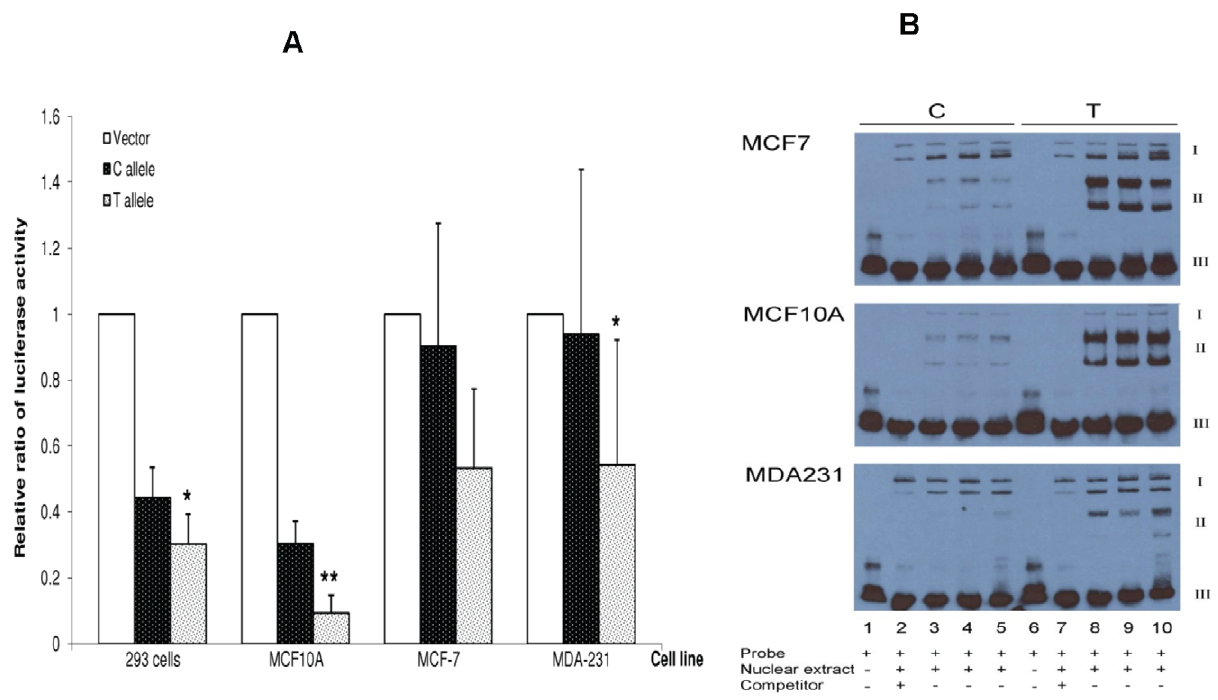
Figure 3. Invitro functional characterization of SNP rs4784227. (A) Effect of rs4784227 on luciferase reporter activity. HEK 293, MCF10A, MCF- 7, and MDA-231 cells were transiently transfected with pGL3 promoter vector and the constructs carrying the reference allele (C) and risk allele (T) of rs4784227, respectively. Relative luciferase activities are shown as mean 6 SD of four experiments (relative to empty vector). Statistical analysis was done using Student’s t-test comparing C and T alleles (* P , 0.05, ** P , 0.01, n=4). (B) Electrophoretic mobility shift assays. Nuclear protein extracts from MCF-7 (top panel), MCF10A (middle panel), and MDA-231 (bottom panel) cells were incubated with biotin-labeled probes corresponding to reference allele C (lanes 1–5) or the risk allele T (lanes 6–10) of rs4784227 in the absence or presence of competitors. Lanes 1 and 6, no nuclear extracts; lanes 2 and 7, unlabeled competitor in 200-fold molar excess; lanes 3 and 8 (5 mM MgCl2), lanes 4 and 9 (2.5 mM MgCl2), and lanes 5 and 10 (1.25 mM MgCl2), no competitor. I: nonspecific DNA-protein complex bands from MCF-7, MCF10A, and MDA-231 cells; II: specific DNA-protein complex bands; III: free biotin-labeled probes.